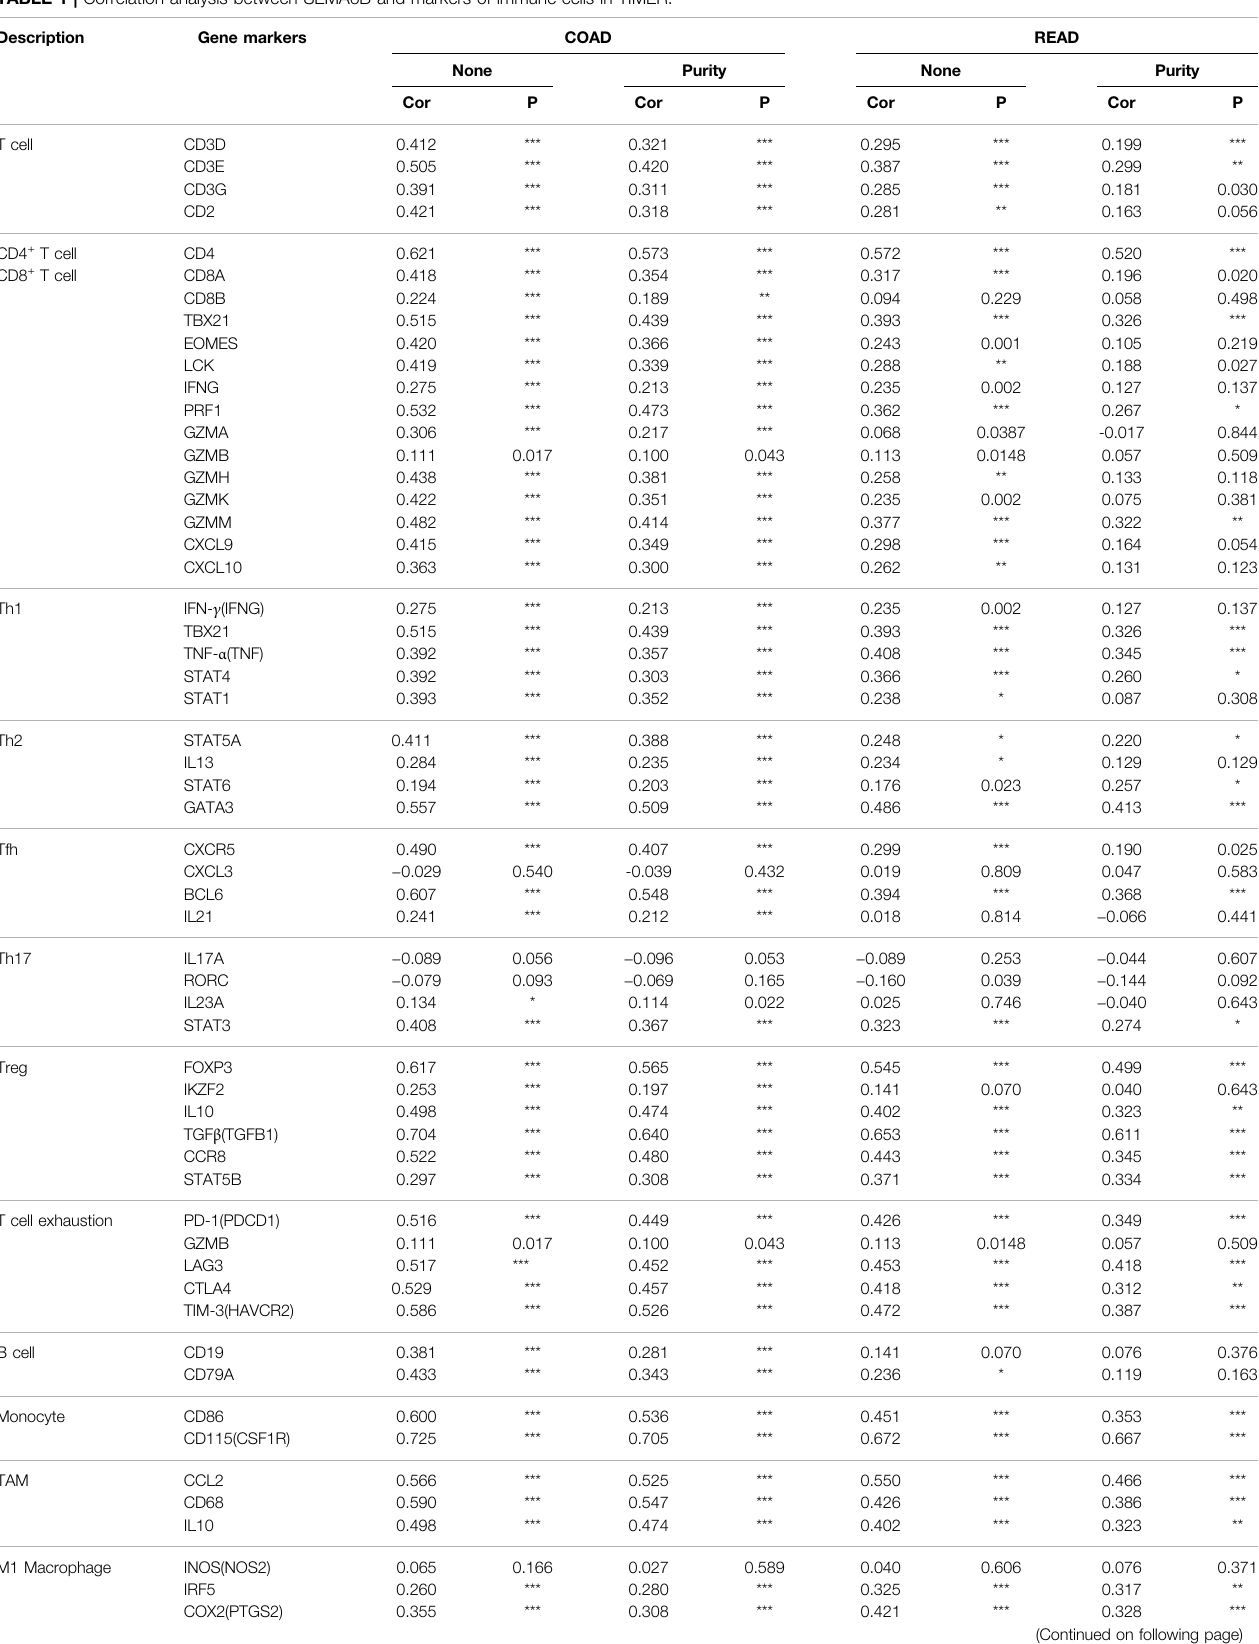
TABLE 1 | Correlation analysis between SEMA6B and markers of immune cells in TIMER.